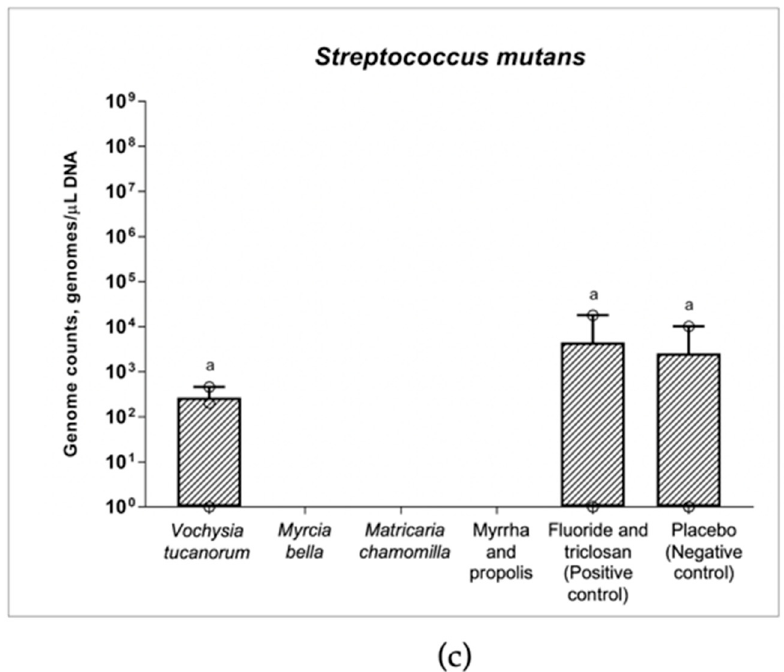
Figure 3. Boxplot of genome counts of total bacteria, Lactobacillus spp., and Streptococcus mutans present in microcosm biofilm after treatments. ( a ) Boxplot of genome counts of total bacteria present in microcosm biofilm after treatments (Kruskal–Wallis/ Dunn’ multiple comparison test, p < 0.0001). ( b ) Boxplot of genome counts of Lactobacillus spp. present in microcosm biofilm after treatments (Kruskal–Wallis/ Dunn’ multiple comparison test, p = 0.003). Lactobacillus spp. (n = 3 Vochysia tucanorum , n = 1 Myrchia bella , n = 6 placebo). ( c ) Boxplot of genome counts of Streptococcus mutans present in microcosm biofilm after treatments (Kruskal–Wallis/ Dunn’ multiple comparison test, p > 0.99). S. mutans (n = 2 Vochysia tucanorum , n = 1 F and triclosan toothpaste, n = 1 placebo). Genomes per microliter of samples were determined by qPCR. Different letters show significant differences among the treatments.